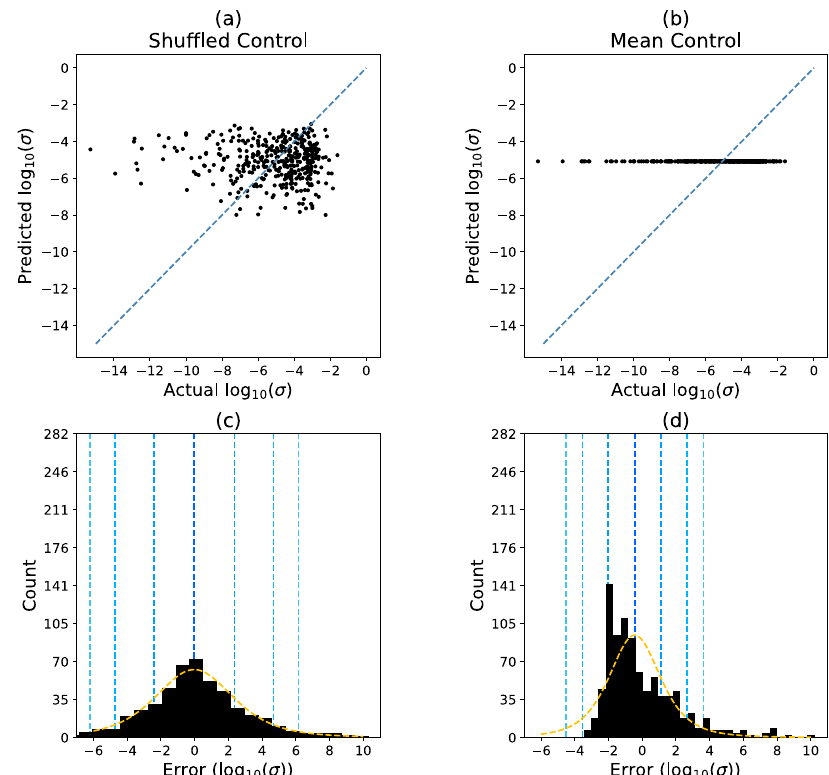
Fig. 5 Parity plots and error distribution for two control studies. a The shuf fl ed control parity plot demonstrates each materials actual conductivity plotted against an average of fi ve randomly selected values across the dataset. c The distribution of errors across all experiments (without averaging) demonstrates the maximal error bounds we would expect from a poor statistical model, with 68% of predictions falling between − 2.36 to 2.31 away from the true values. b The mean control experiment demonstrates the expected predictions for a model which has simply learnt the mean value of the dataset. Correspondingly, the distribution of errors ( d ) is simply a re fl ection of the distribution of conductivities around the mean value, and models which form predictions close to the mean will resemble this distribution. A Student ’ s t-distribution (orange) is fi t to the underlying data, with the mean of this distribution (dark blue), and the fi rst, second, and third standard deviations away from this mean (light blue) overlaid in ( c ) and ( d ). A good model should have a mean of zero, with tight error